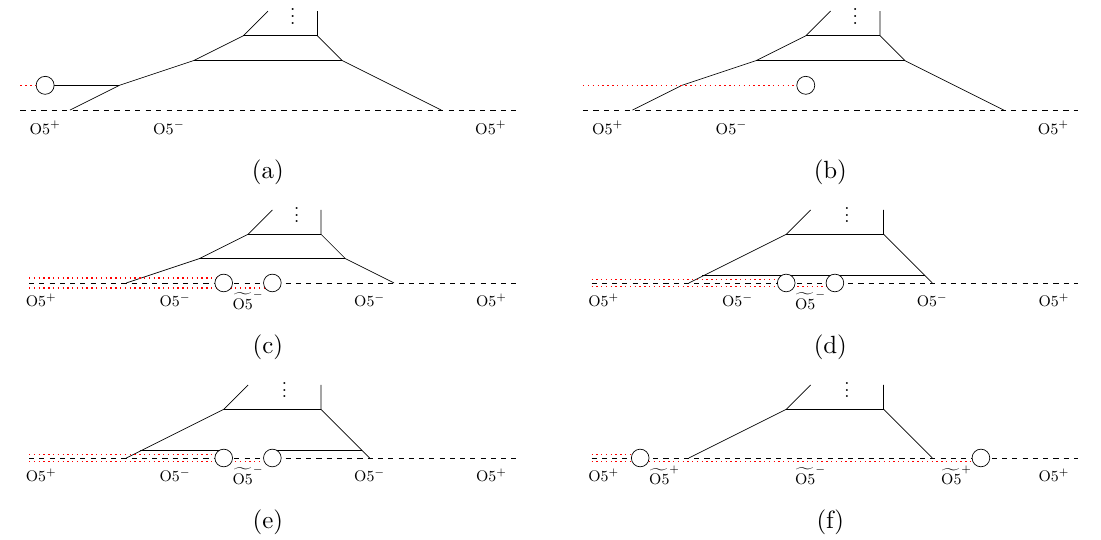
Figure 7. Higgsing in the 5-brane web. In (a), a single half D7 has been moved towards one of the O5-planes as compared to the configuration in figure 4(b). The red dotted line denotes the half monodromy cut of the 7-brane. In (b), the half D7 has been moved inside the 5-brane web. During this process, the half 5-brane that connected the D7 and the web has been annihilated. In (c), the half D7 has been moved onto the orientifold plane, where it meets its mirror image. Subsequently, the two half D7-branes can be separated along the O5. Following charge conservation, the orientifold − between the two half D7 is a f O5 . In (d), a half D5 gauge brane (together with its mirror half brane) has been moved onto the orientifold. The D5 can be split along the half D7-branes, such that a Higgs branch direction opens up. In (e), the full D5 segment between the half D7-branes has been moved along the Higgs branch direction off to infinity. In (f), the half D7-branes have been moved out of the 5-brane web, during which the attached 5-branes have been annihilated. As a result, the 5-brane web is now on top of a f O5